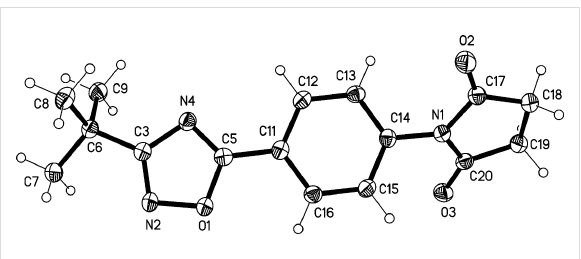
Figure 7: Molecular structure of 1-(4-(3- tert -butyl-1,2,4-oxadiazol-5- yl)phenyl)pyrrolidine-2,5-dione ( 4 ). Atoms are drawn as 50% thermal